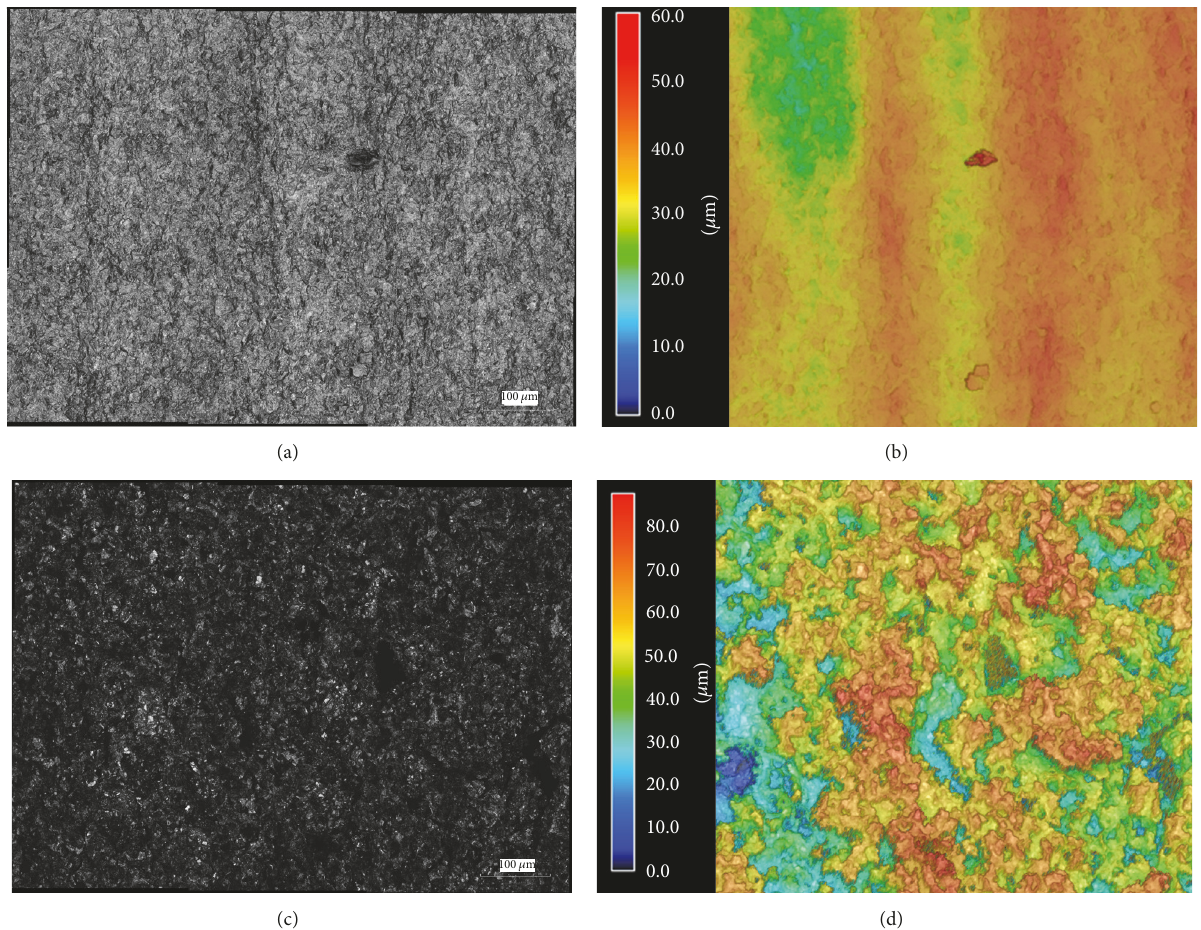
Figure 6: (a, b) Laser microscope and 3D topography images of oven-cured W1 and (c, d) photonic-cured W2.